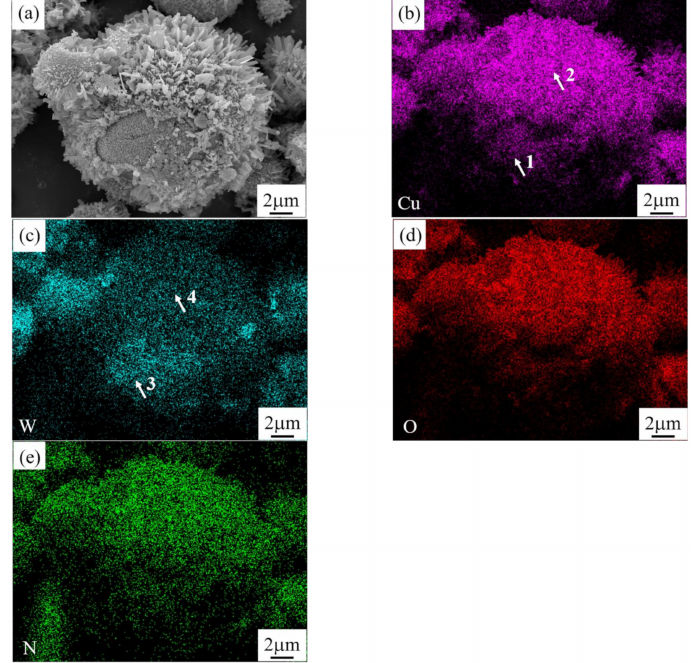
Figure 4. EDS distribution diagram of the enlarged view of the region C in Figure 3d: ( a ) SEM; ( b – e ) Distribution of element.